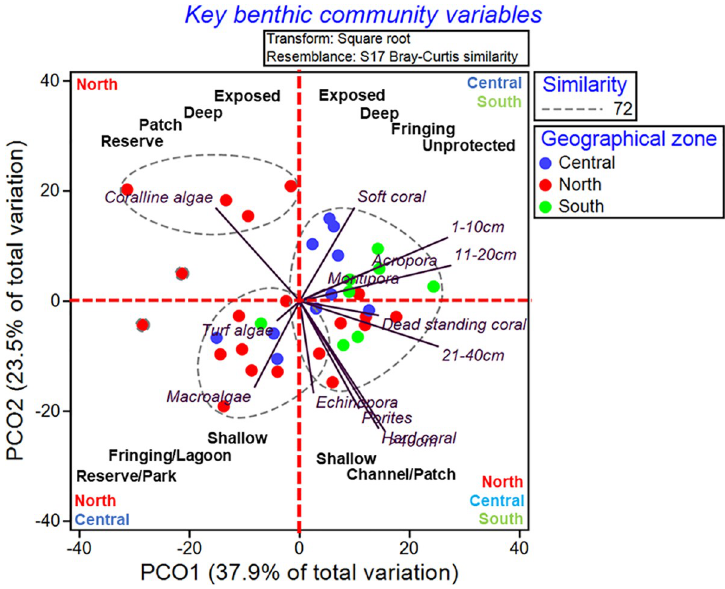
Fig 4. Principal Coordinate analysis (PCoA) of key benthic communities. Clusters of 38 reef sites based on Bray– Curtis index. Embedded in each quadrant of the PCO is interpretation of the habitat factors and management levels associated with the clustering of